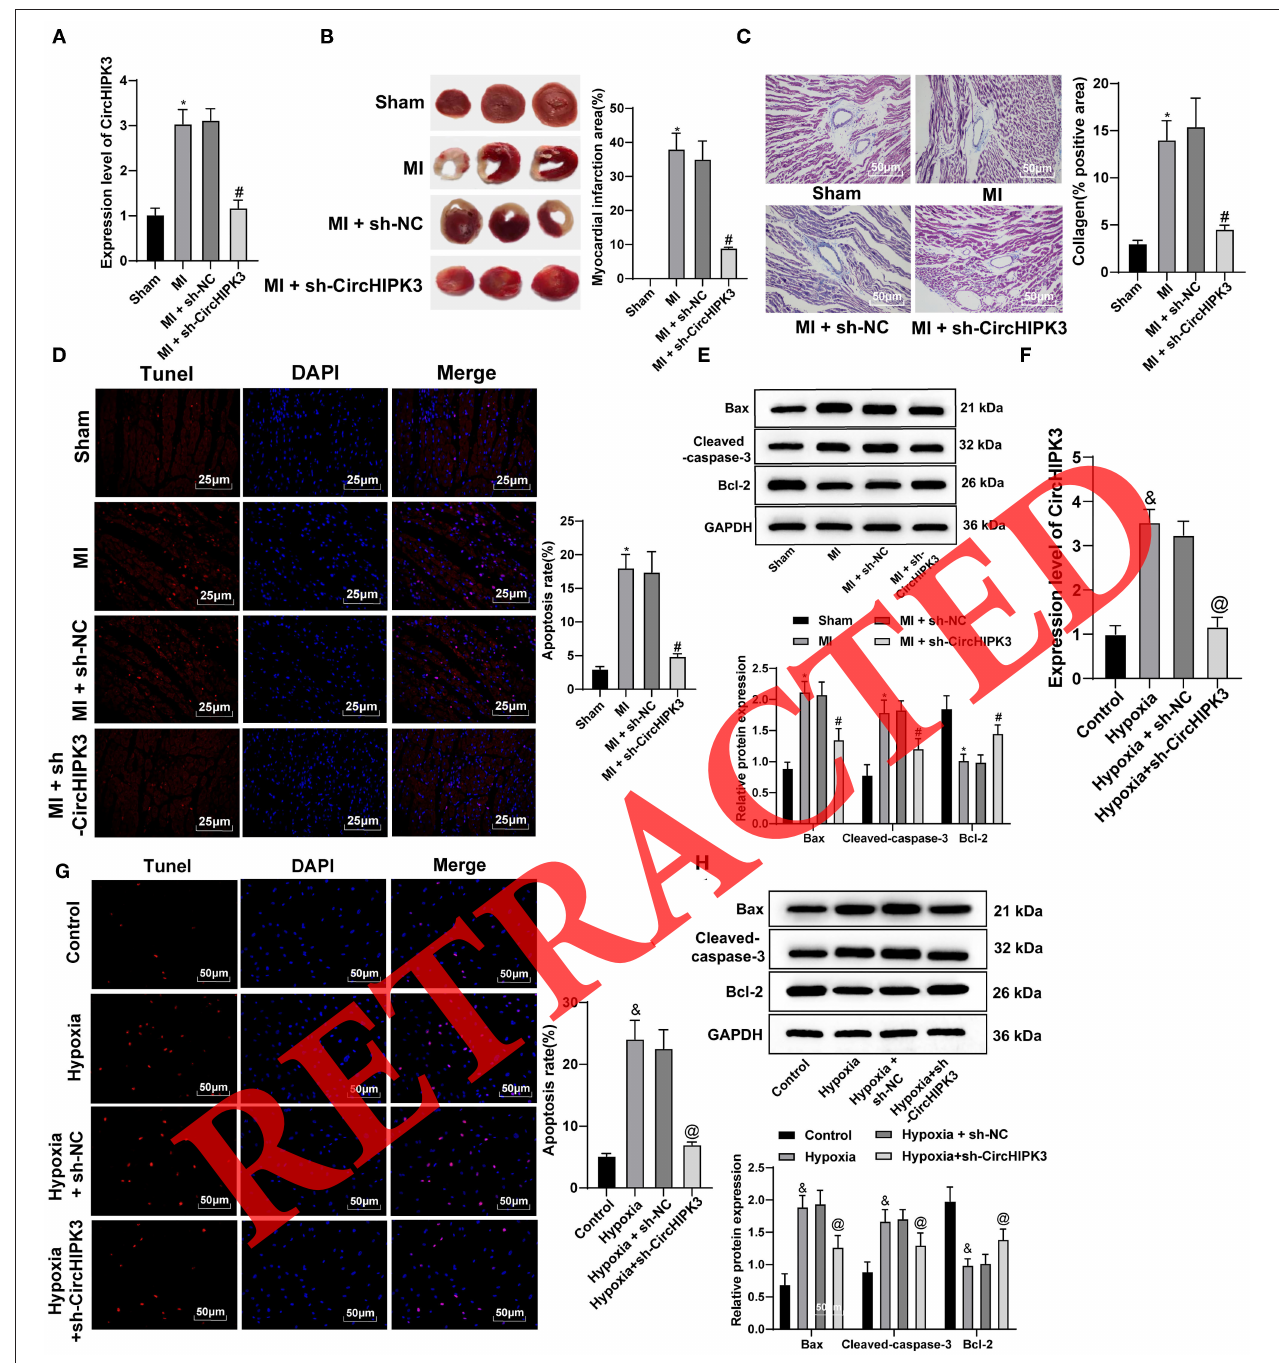
FIGURE 2 | CircHIPK3 downregulation can reduce cardiomyocyte apoptosis after myocardial infarction (MI) and improve cardiac function. (A) RT-qPCR detected the expression of CircHIPK3 in myocardial tissue. (B) 2,3,5-Triphenyltetrazolium chloride staining was used to detect infarct size. (C) Masson staining was used to detect collagen deposition. (D) TUNEL staining was used to observe the apoptosis of myocardial tissue. (E) The expression of Bax, cleaved caspase-3, and Bcl-2 protein, respectively, was detected by Western blot analysis. (F) RT-qPCR detected CircHIPK3 expression in cardiomyocytes in vitro . (G) The apoptosis of cardiomyocytes was detected by TUNEL staining. (H) Western blot analysis detected the expression of Bax, cleaved caspase-3, and Bcl-2 protein. The value in the figures is the measurement data, which is expressed as mean ± standard deviation. The comparison among multiple groups was analyzed by one-way ANOVA, followed by Tukey’s multiple-comparisons test. *compared with sham group, p < 0.05; # compared with MI + sh-NC group, p < 0.05; & compared with control group, p < 0.05; @ compared with hypoxia + sh-NC group, p < 0.05. The experiment was repeated three times.